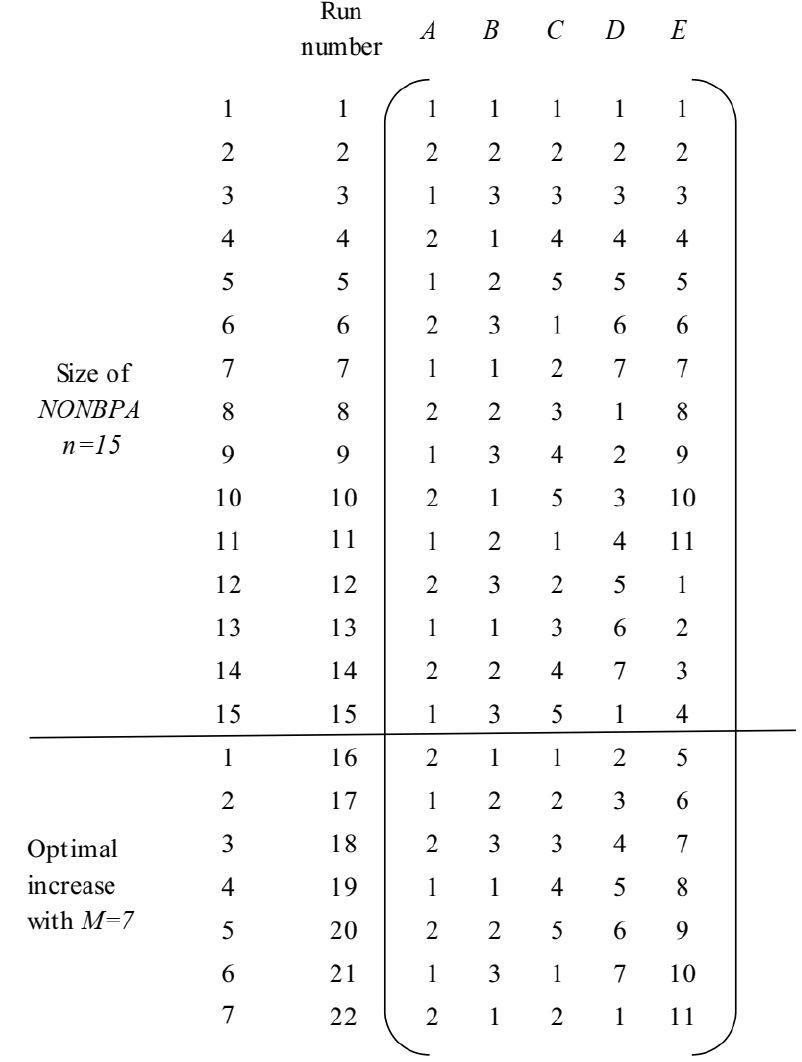
Figure 7. NONBPA (15,2 1 3 1 5 1 7 1 11 1 ) augmented with 7 runs.